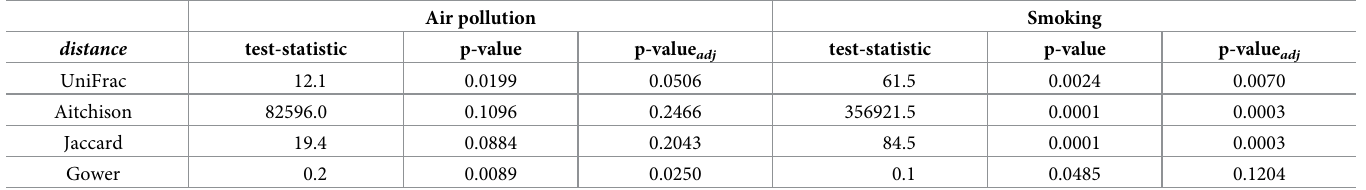
Table 5. β -diversity. Microbiome Regression-based Kernel Association Test ( MiRKAT ), unadjusted and adjusted one-sided randomization-based p-values for 10,000 per- mutations of the intervention assignment following a matched-pair design. Air pollution Smoking